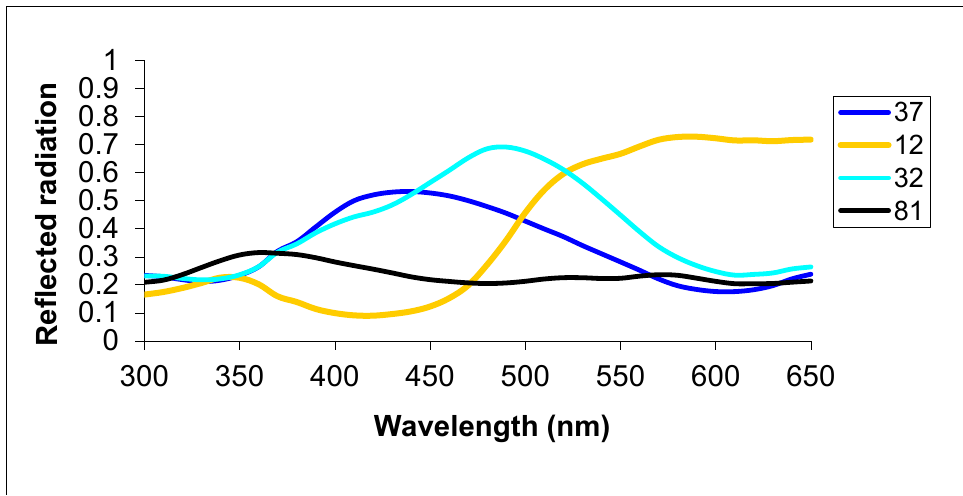
Figure 1. Spectral reflectance of the four Tonpapier (Baehr, Germany: code number shown) cards used as stimuli. The colour of the lines approximately matches the colour of the cards considering human trichromatic